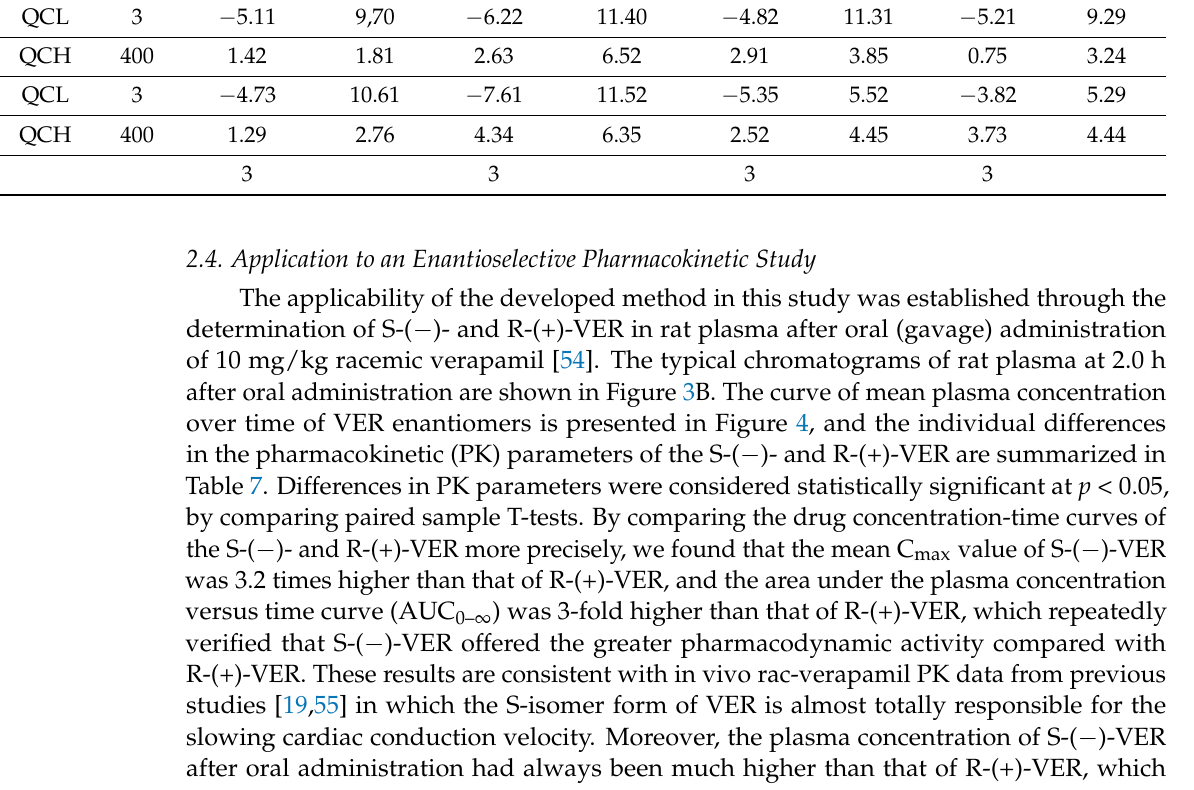
Table 6. Stability results for S-( − )- and R-(+)-verapamil in rat plasma under different storage conditions.